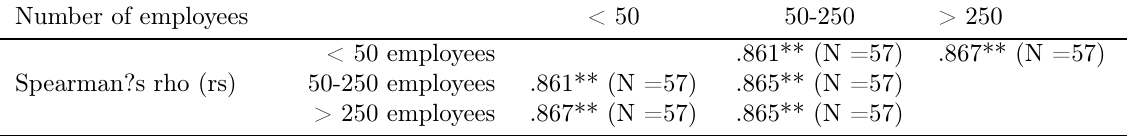
Table 7. Ranking correlations between the enterprise